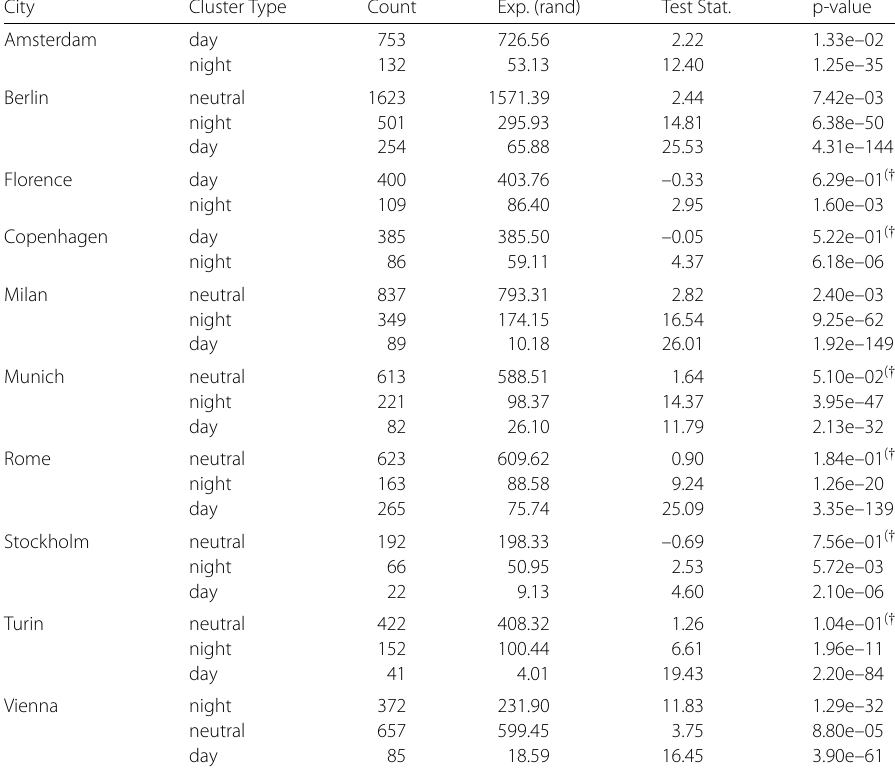
Table 5 Join Count Statistics. Column Count contains the total number of matches; column Exp. (rand) contains the number of matches expected under random; Test Stat. contains the test statistics; ( † ) denotes p-values greater than 0.05 (not statistically significant). Neighbour cells are obtained using the Queen criterion (i.e., assuming moves like the Queen in a chess game); spatial weights are binary City Cluster